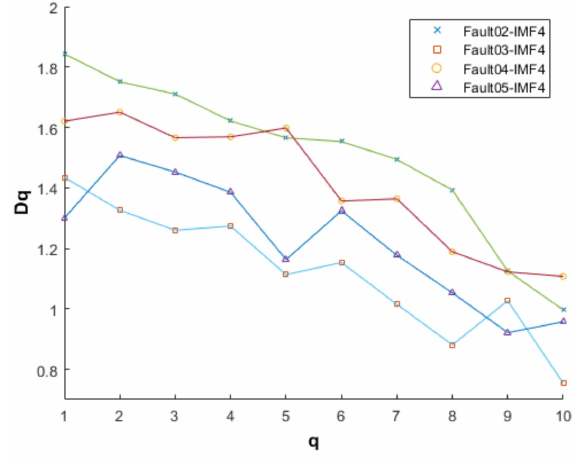
Figure 26. IMF4‑VMD mathematical morphology fractal dimension map. Table 5. Characteristic sample of the fault signal analysis